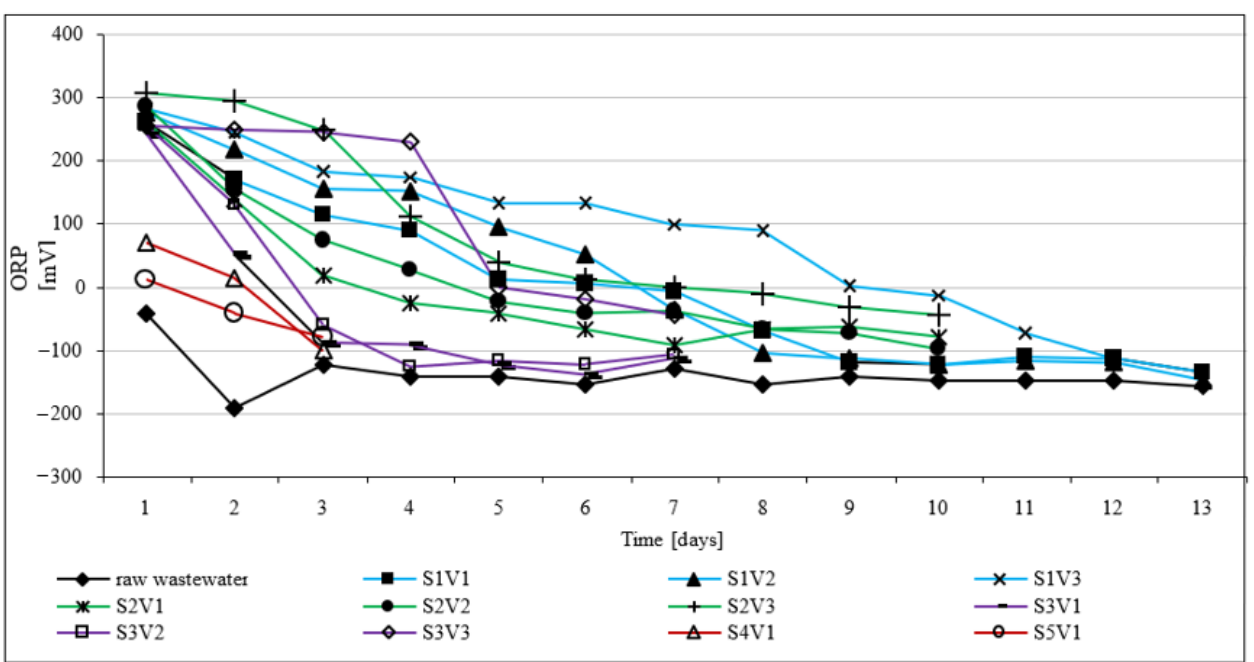
Figure 3. Changes in oxidation–reduction potential across variants.